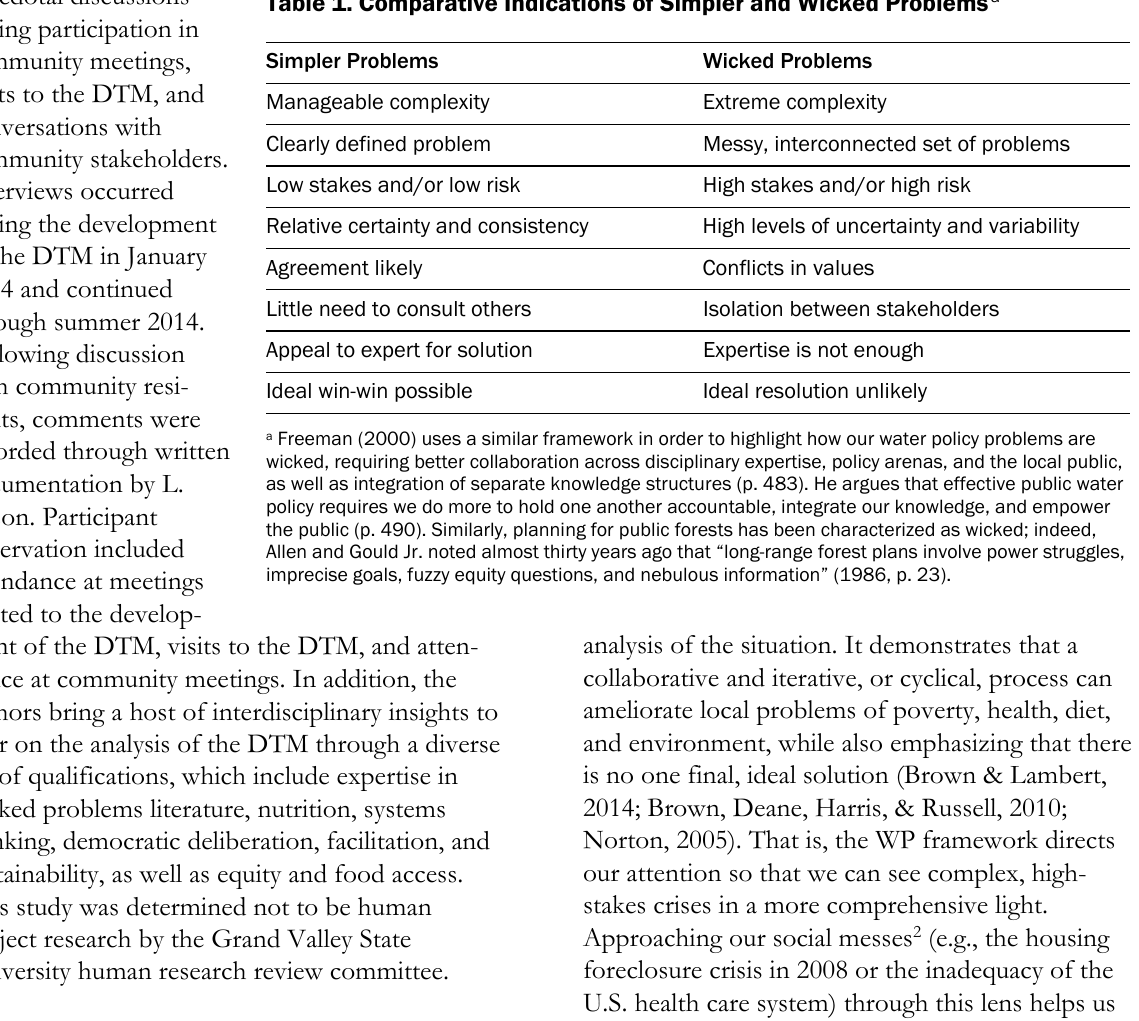
Table 1. Comparative Indications of Simpler and Wicked Problems a